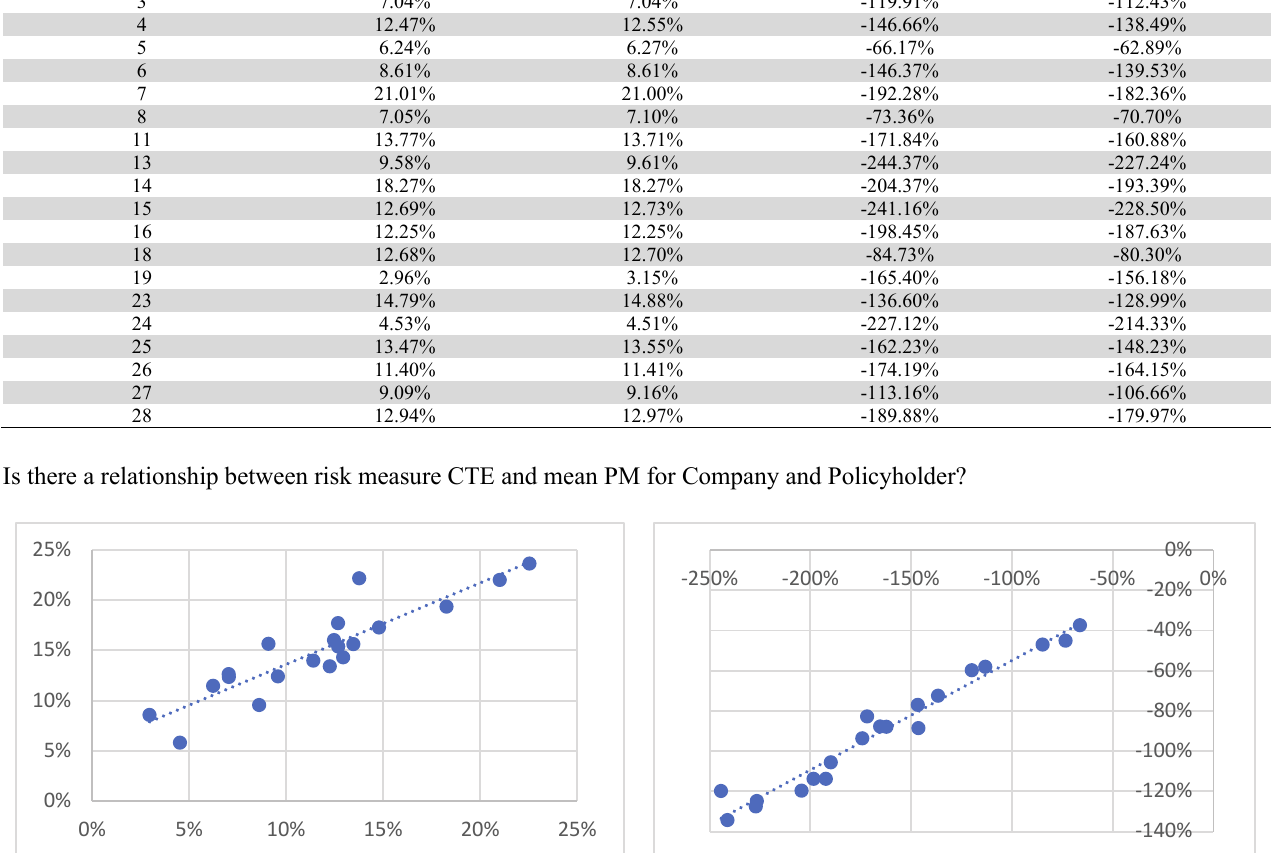
Fig. 3. Correlation between CTE and Mean of PM for Company